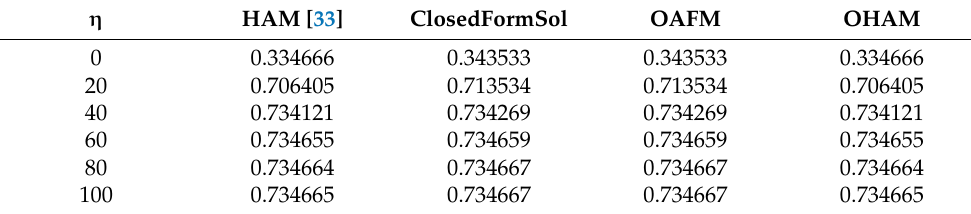
Table 3. Comparison of solutions for h ( η , t ) at α = 1.